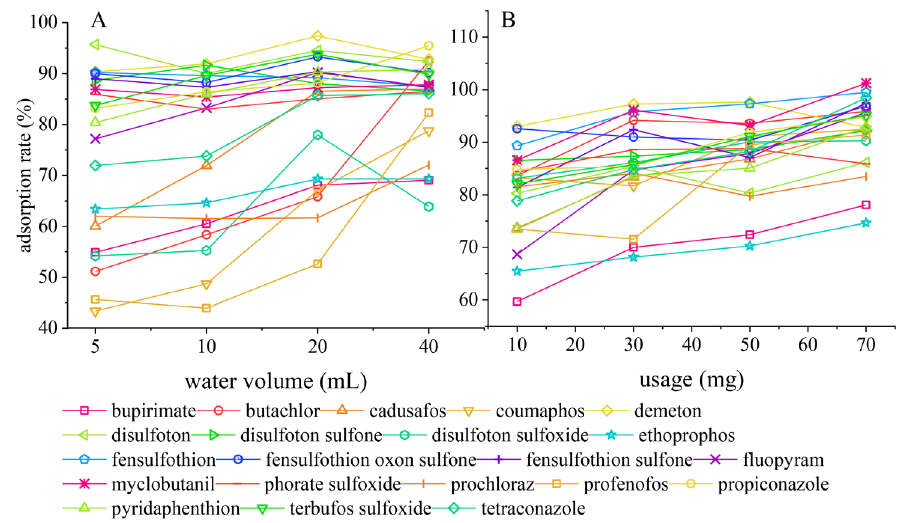
Figure 2. The effect of sample volume ( A ) and absorbent dosage ( B ).